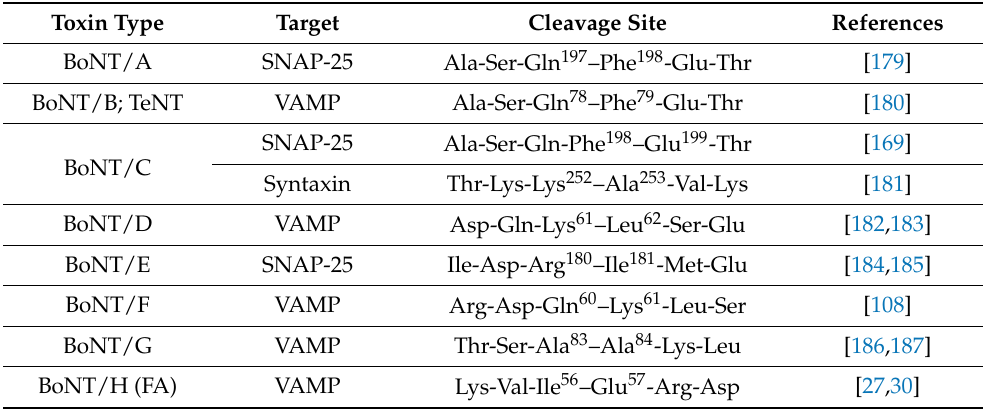
Table 2. Clostridial neurotoxin targets and peptide bond